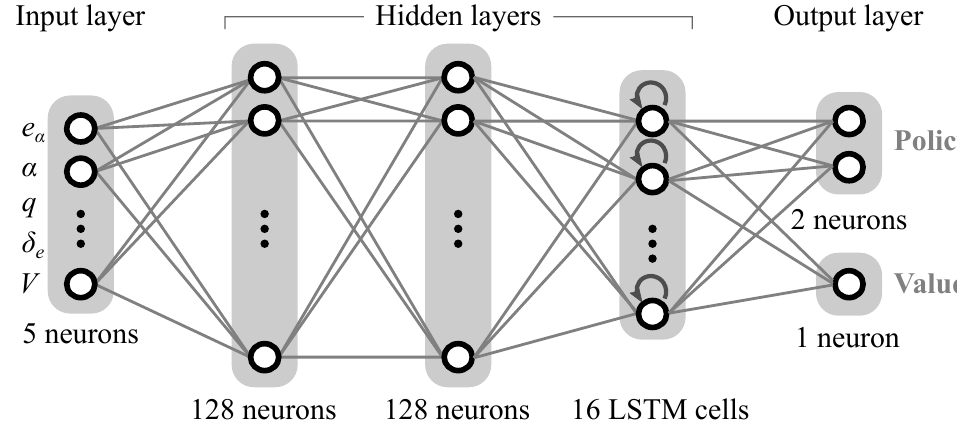
Figure 4. Neural network architecture.